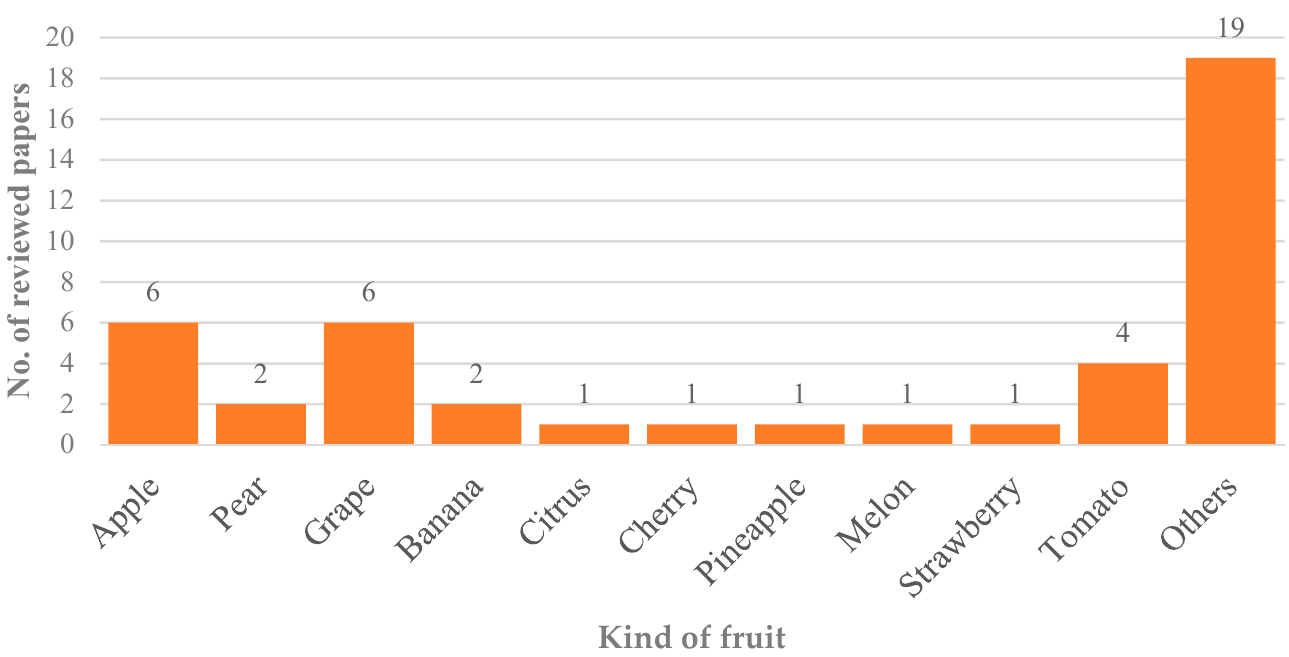
Figure 3. Statistics related to the fresh fruit supply chain research in term of fruit species from 1978–2017.